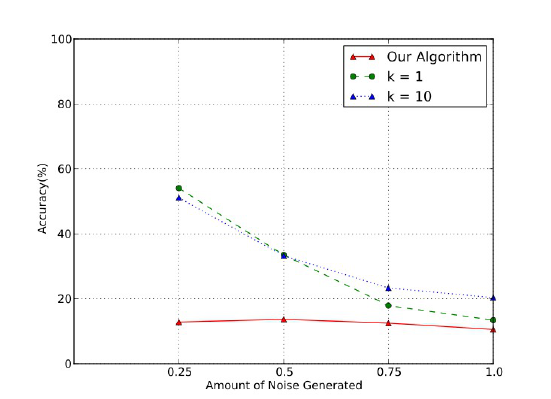
Figure 6. The accuracy using the Random Forest algorithm when introducing different kinds of cover traffic.